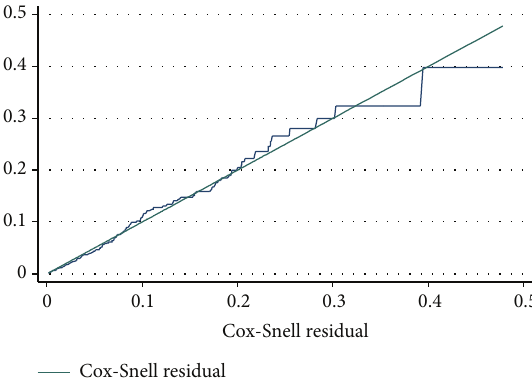
Figure 5: Cumulative hazard plot of the Cox-Snell residuals of the proportional hazards Cox regression model in Table 7. The 45- degree straight line through the origin is drawn for